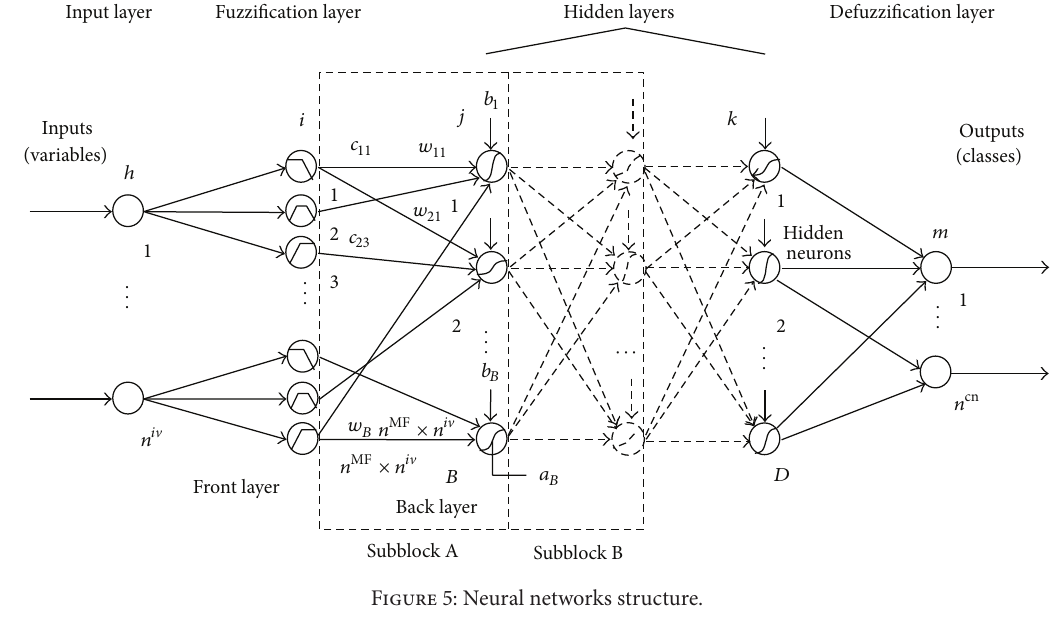
Figure 5: Neural networks structure.